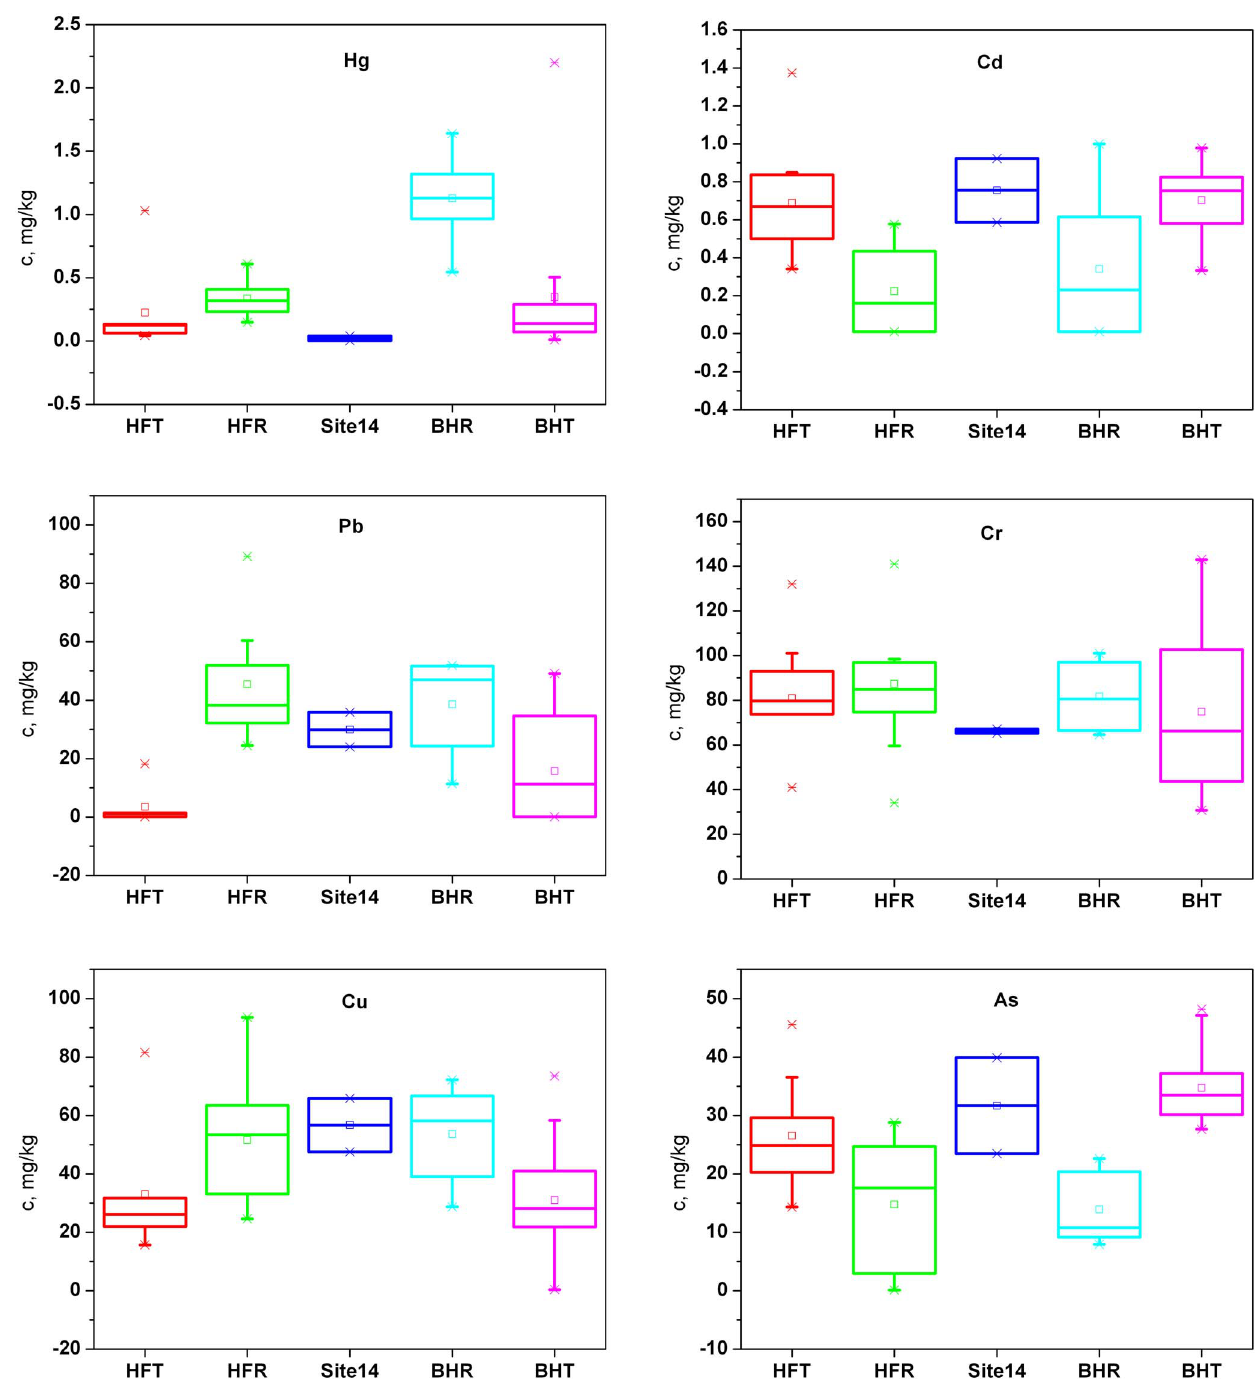
Figure 5. Comparison of heavy metal concentrations in sediments. (HFT: sites at inlets of main tributaries in the Hongfeng Reservoir, namely sites 1–5; HFR: representative sites within Hongfeng Reservoir, namely sites 6–13; BHT: sites at inlets of main tributaries in the Baihua Reservoir (except site 14), namely sites 15–22; BHR: representative sites within the Baihua Reservoir, namely sites 23–26).